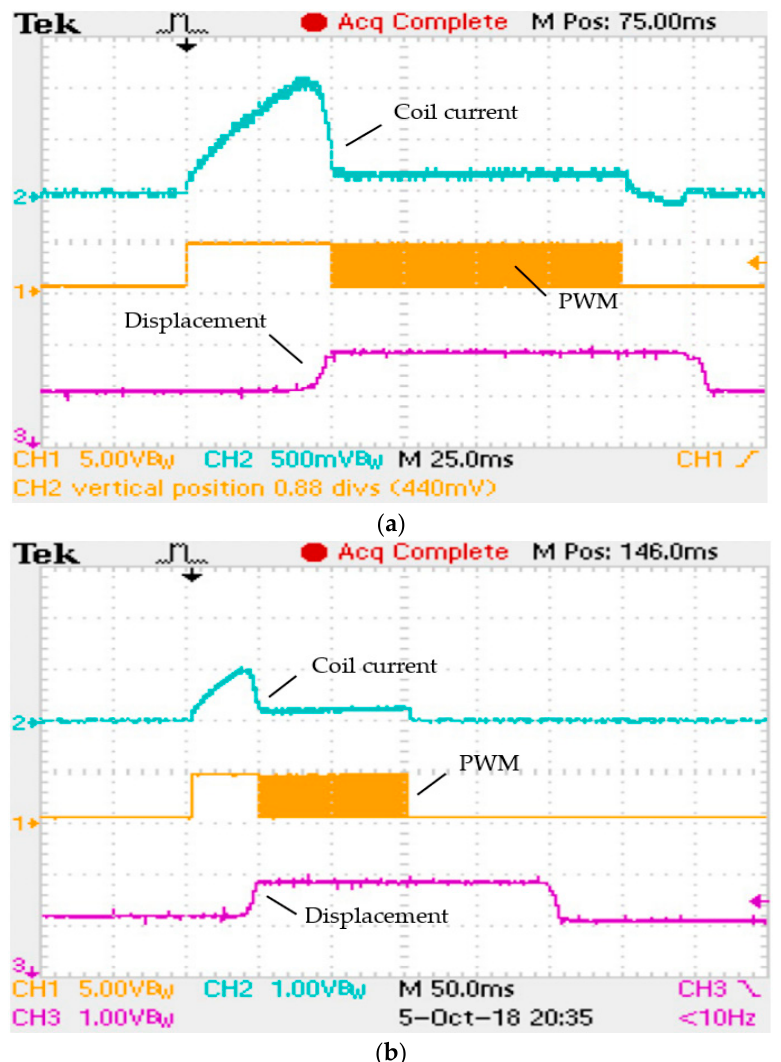
Figure 11. Experimental results. ( a ) With reverse voltage. ( b ) Without reverse voltage. (For the coil current, 1 A corresponds to 1 V; for the movable iron core displacement, 1 mm corresponds to 250 mV.).